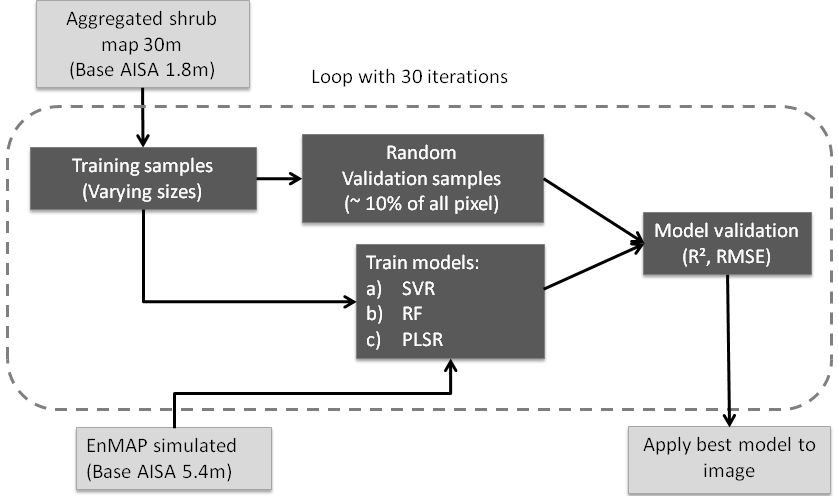
Figure 3. Workflow of the analysis. Light grey boxes contain input and output products, dark grey boxes show steps during the analysis. Steps within the broken line were repeated 30